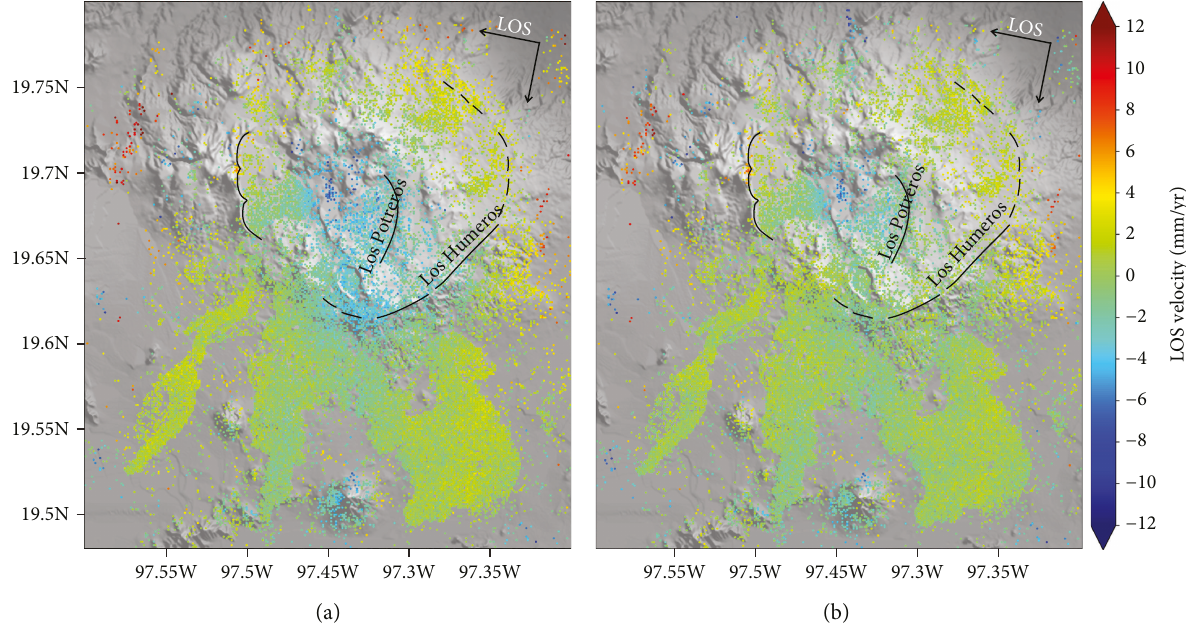
Figure 5: Deformation maps showing the mean velocities in the satellite line of sight (LOS) in mm/year (a) without tropospheric correction and (b) corrected for topography-related tropospheric phase delays. Movements are relative to the mean of the whole area. Negative values indicate movement away from the satellite ( ~ subsidence) and positive values indicate movement towards the satellite ( ~ uplift). The black rectangle in (a) highlights the region used to calibrate the tropospheric